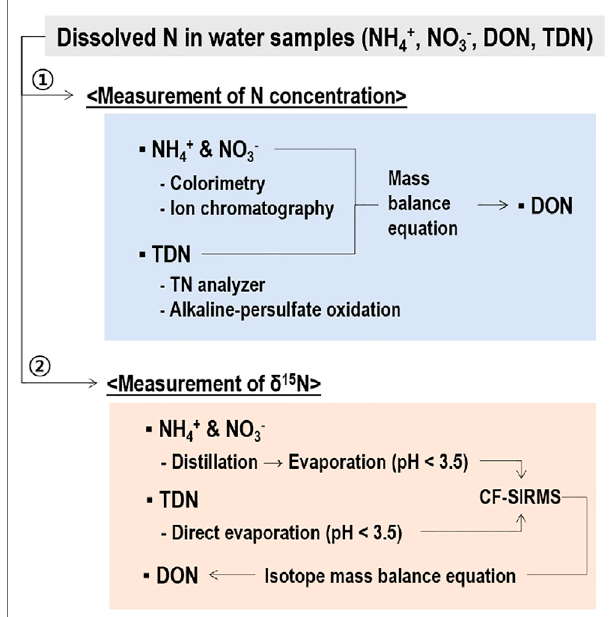
FIGURE 5 | A scheme of simultaneous determination of δ 15 N of NH 4+ , NO 3 ‒ , DON, and TDN using distillation and evaporation. Determination of N concentration prior to δ 15 N measurement is recommended to decide sample volume for distillation.